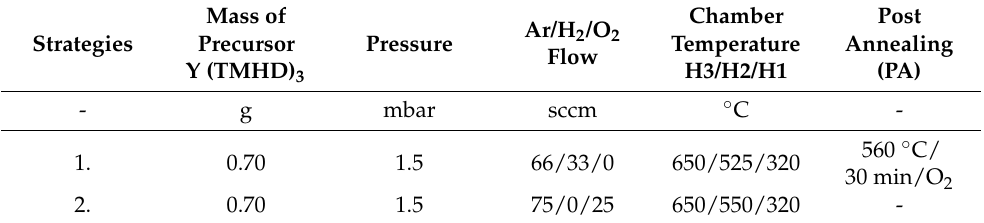
Table 1. Experimental strategies with used parameters for the MOCVD process. Mass Strategies